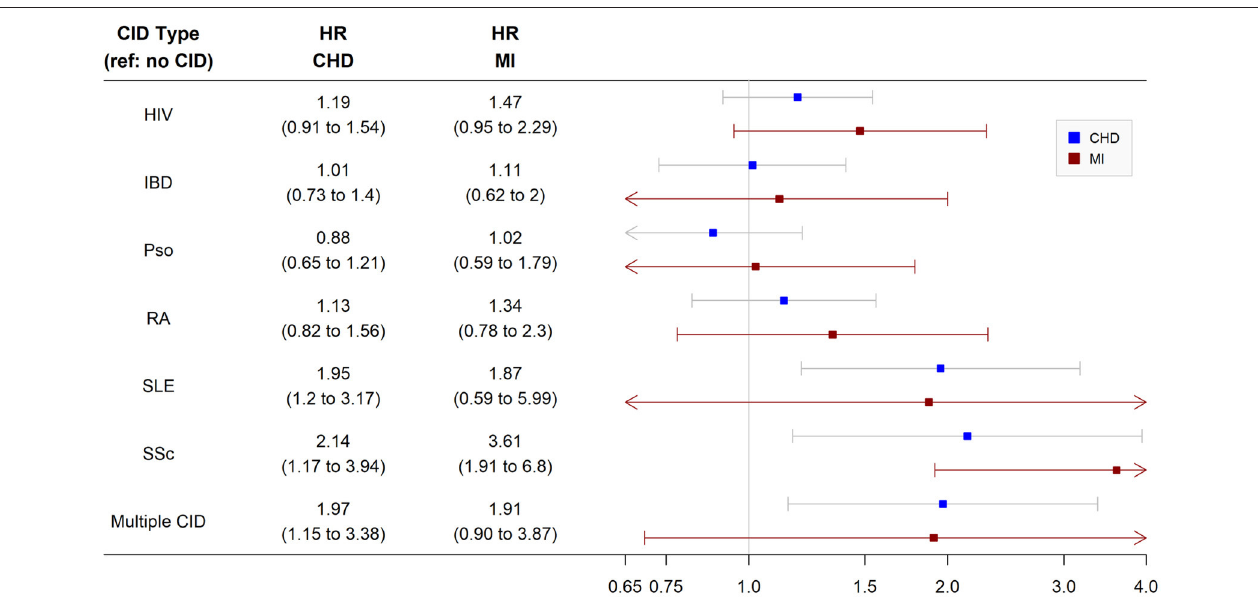
FIGURE 2 | Risk of incident coronary heart disease and myocardial infarction among chronic inflammatory disease groups. Analysis performed in nested cohort. Cox proportional hazard ratios adjusted for age, sex, race/ethnicity, insurance, baseline year, hypertension, diabetes, current smoking, total cholesterol, statin use, and systemic steroid use. CHD, coronary heart disease; MI, myocardial infarction; HR, hazard ratio; CID, chronic inflammatory disease; HIV, human immunodeficiency virus; RA, rheumatoid arthritis; SLE, systemic lupus erythematosus; SSc, systemic sclerosis; IBD, inflammatory bowel